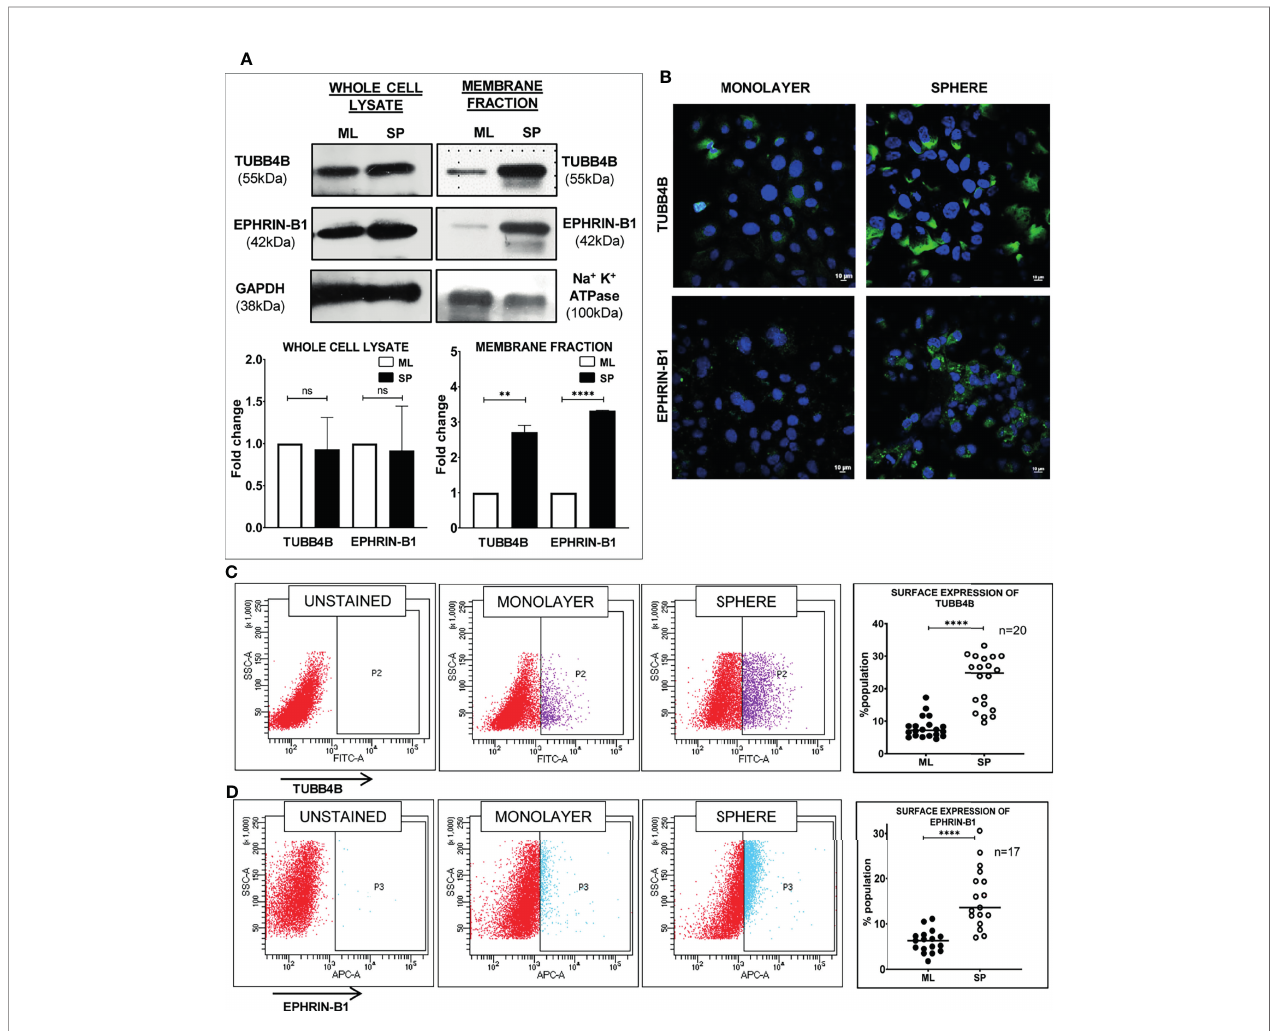
FIGURE 5 | Sphere culture enriches the surface expression of TUBB4B and Ephrin-B1. (A) Whole-cell lysates and membrane fractions of sphere and monolayer cultures of HSC-3 cells were immunoblotted. For whole-cell lysates, GAPDH was used as loading control, whereas Na + /K + -ATPase was used as loading control for membrane fractions. The fold changes were calculated and represented graphically. (B) Shows the membrane expressions of TUBB4B or Ephrin-B1 in unpermeabilized monolayer (ML) and sphere cultures (SP). PFA fi xed HSC3 sphere or monolayer cultures were probed for (C) TUBB4B or (D) Ephrin-B1 using fl uorophore tagged primary antibodies and the surface expressions were analyzed by fl ow cytometry. The graphs represent the percentages of cells with high surface expression of individual proteins. ns represents non-signi fi cant data, ** represents p < 0.01, **** represents p <